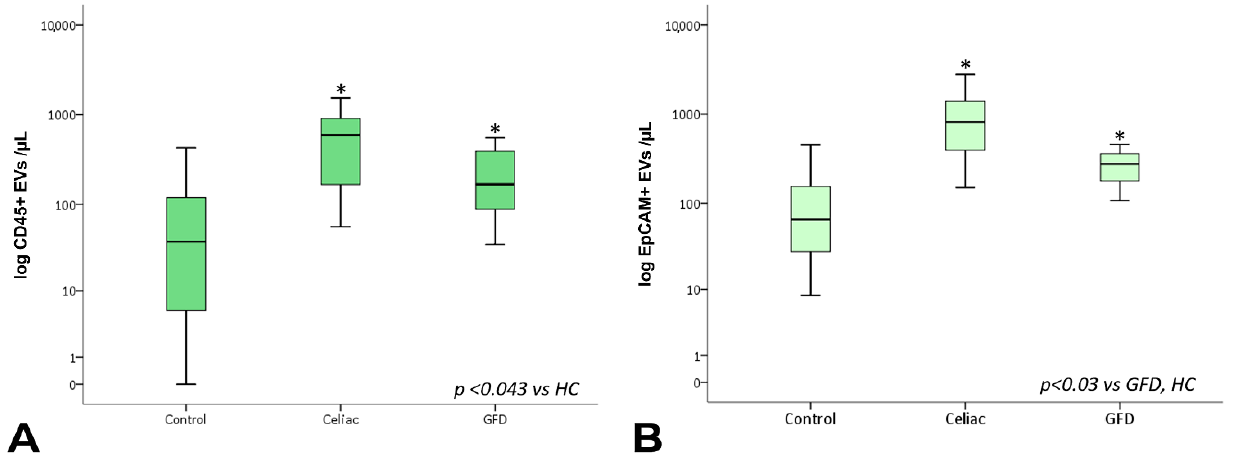
Figure 4. Total CD45+ and EpCAM+ EV counts. Box plots represent CD45+ ( A ) and EpCAM+ ( B ) EV concentrations (EVs per µL, log-transformed) in peripheral blood obtained from controls, celiac, and GFD patients. The horizontal line represents the median value. The asterisk (*) identifies statistically significant differences.